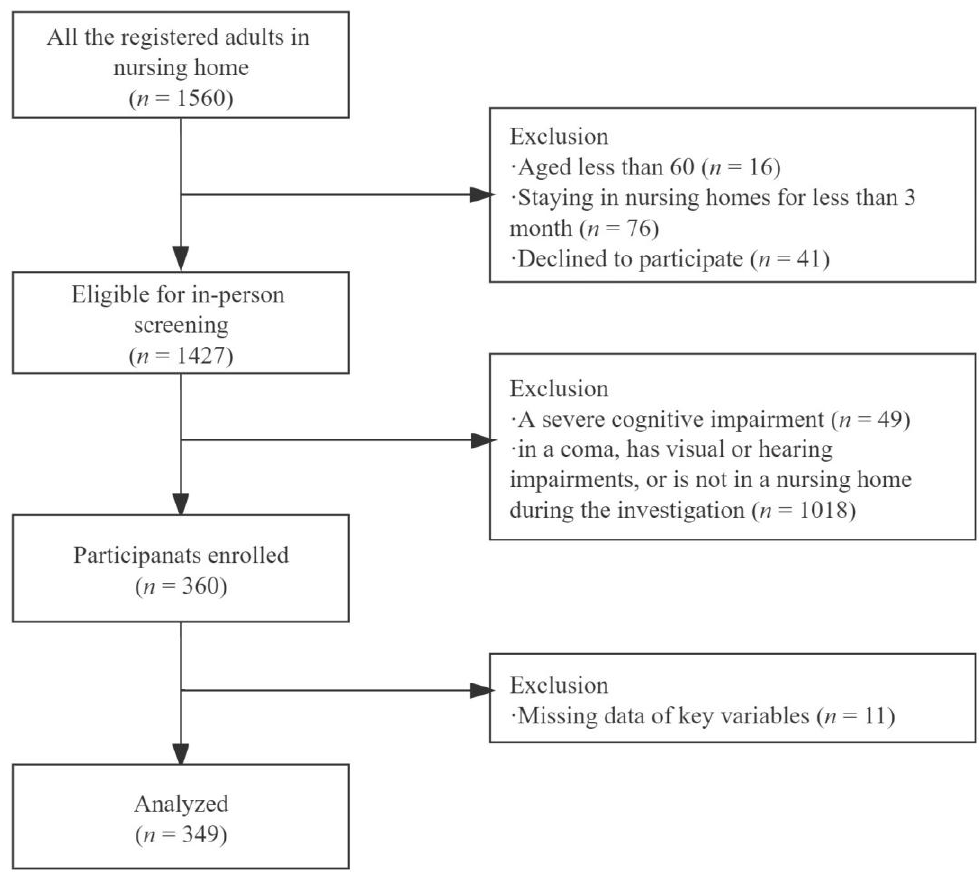
Figure 1. Study flow chart for sample selection. Table 1. Sample characteristics ( n =